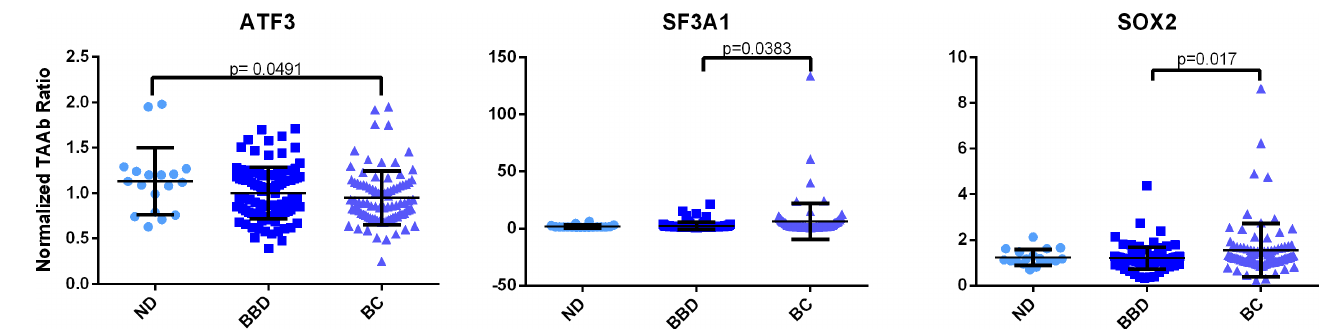
Fig 3. TAAb Expression across Patient Groups. Shown is comparison of no disease (ND), benign breast disease (BBD), breast cancer (BC). Graphs are shown with y-axis represented as normalized TAAb ratio, wherein the target signal is normalized against sample background.